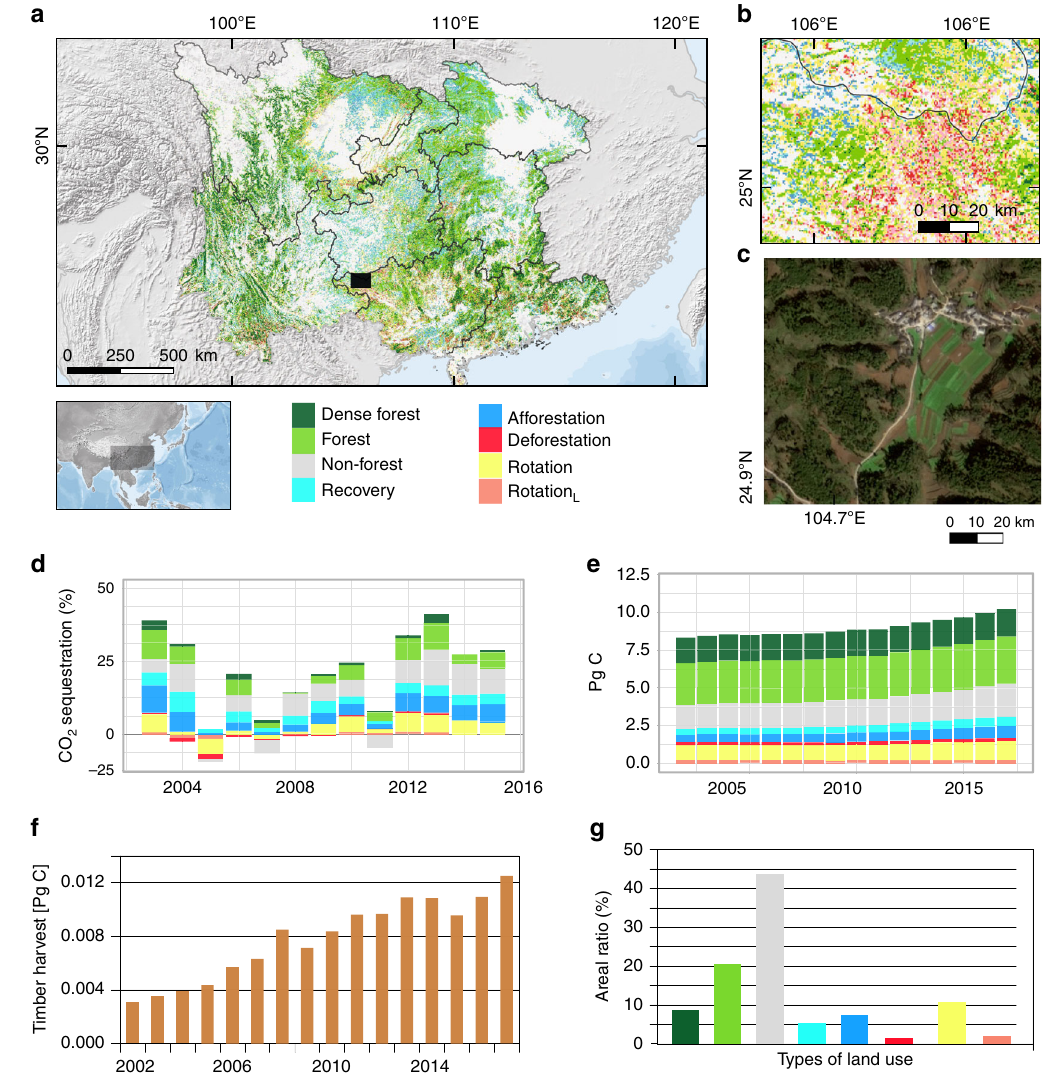
Fig. 4 Land use in southern China. a The area classi fi ed into the eight types of land use. b Forestry is particularly common in northern Guangxi. This close- up is shown as a black rectangle in a . c Forestation of farmlands on sloping hills is a major reason for the increase in forests. This example image (GF-1, 2-m resolution) is also from northern Guangxi (not the same area as b). d Contributions of the types of land use to store fossil CO 2 emissions for the eight provinces in southern China (considering net C changes) from 2002 to 2015. e C stocks for the types of land use from 2002 to 2017. f Annual timber harvest (from forestry statistics at province level; n = 8) converted to Pg C. g Areal ratios of the types of land use. See Supplementary Figs. 5, 6 for close-up illustrations. Source data are provided as a Source Data fi